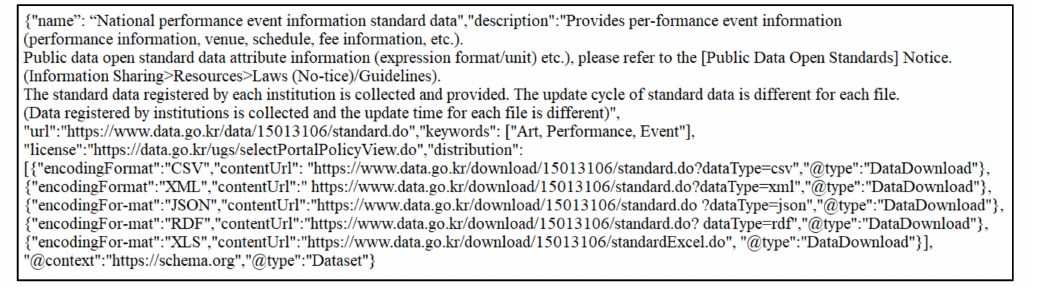
Figure 4. Metadata showing lists of API to download data in different standardized formats shown in the OGDP of South